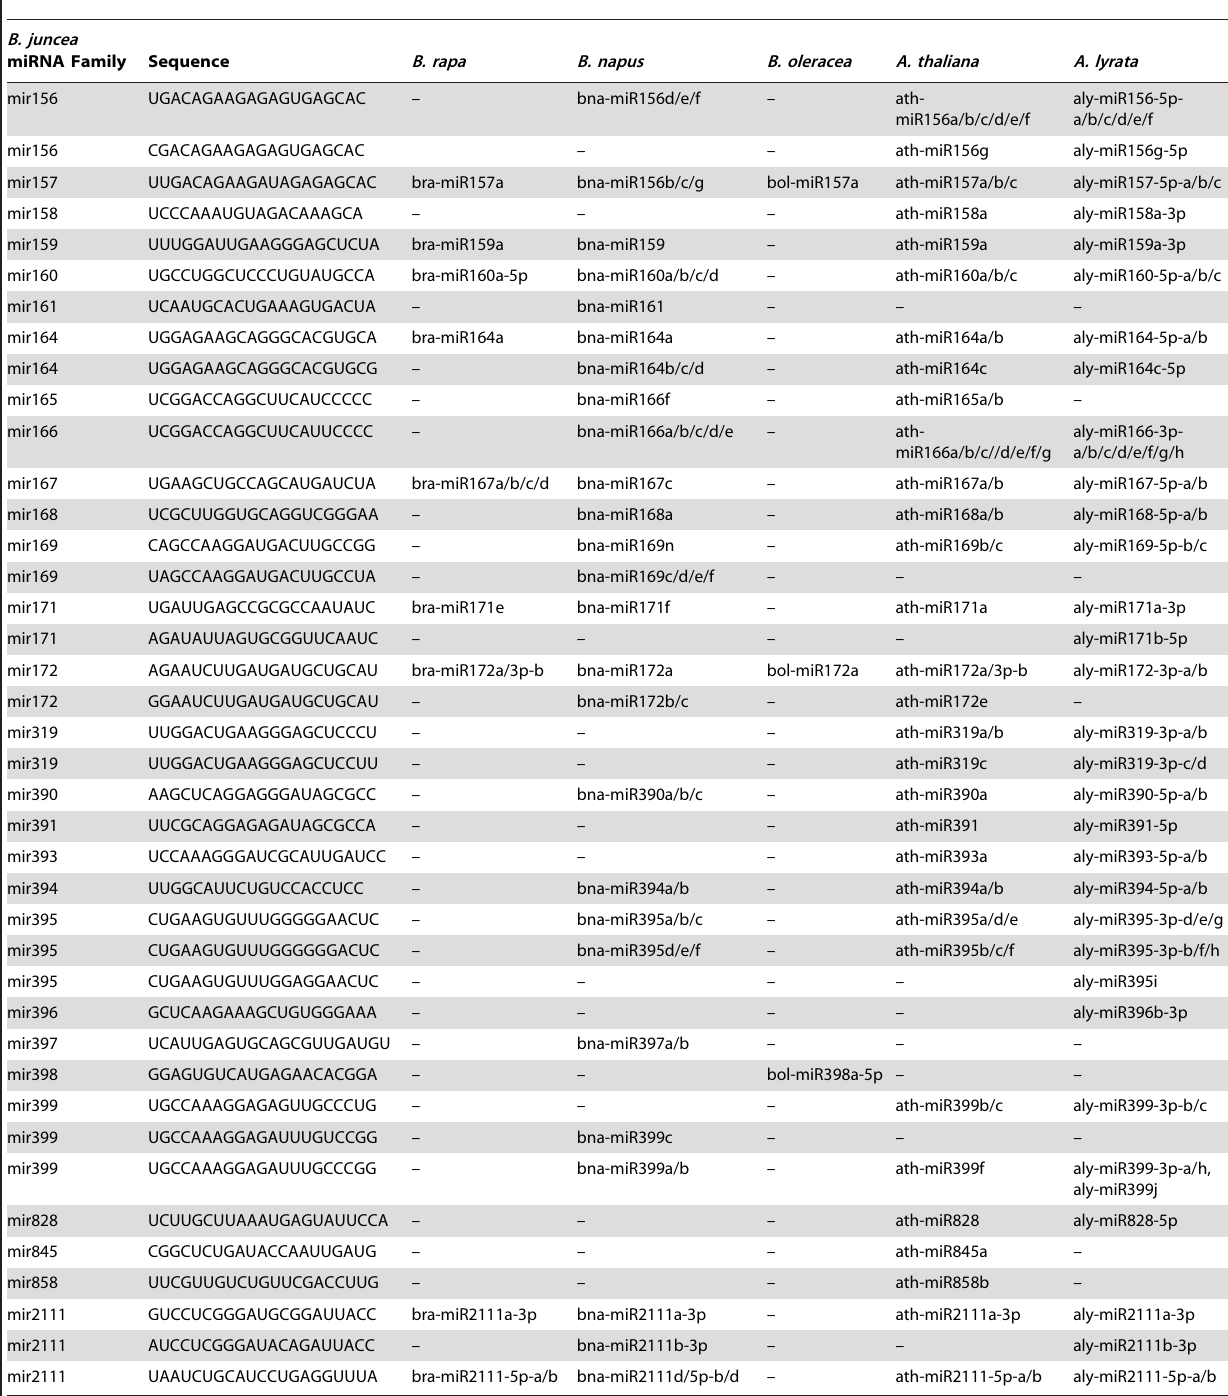
Table 3. The miRNA sequences identified in B. juncea were analysed for identical matches in family Brassica